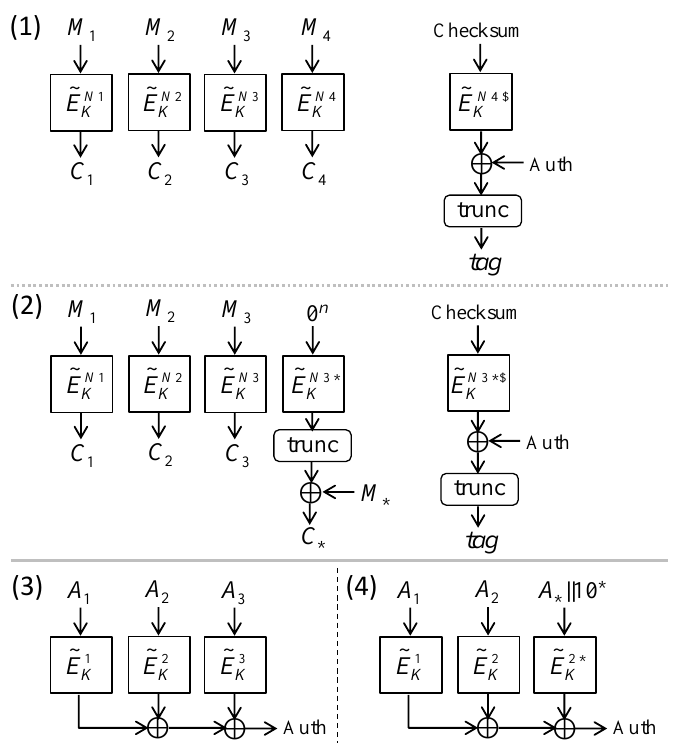
Figure 4: Encryption of ΘCB3. The procedure (1) encrypts four n -bit plaintext blocks M 1 , M 2 , M 3 , M 4 , and returns a tag. The procedure (2) encrypts three n -bit